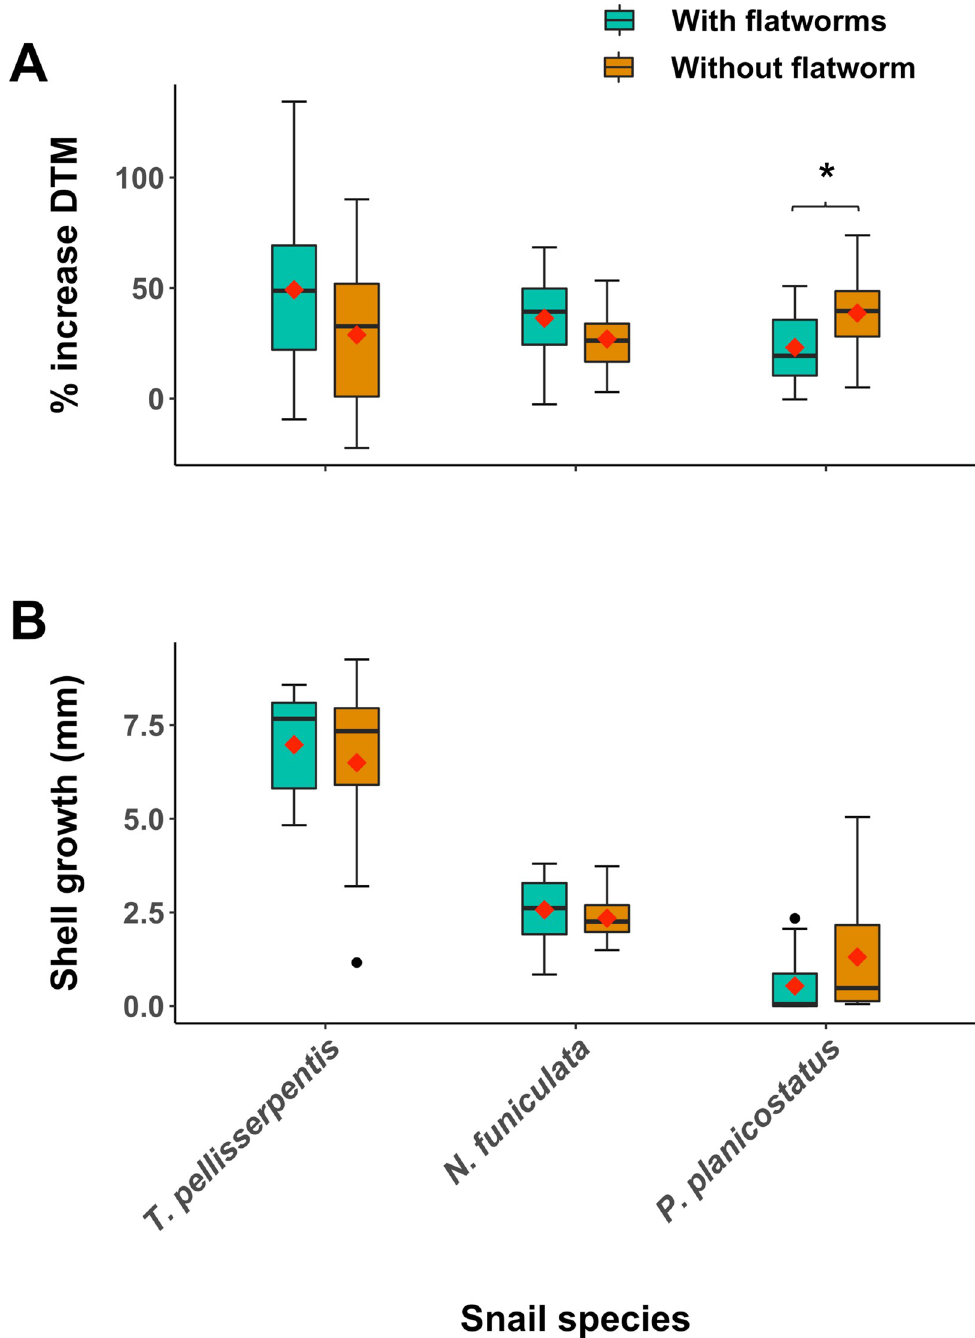
Fig 4. Effect of flatworm infestation on snail growth performances. Box plots of (A) percentage increase in snail dried tissue mass (DTM) and (B) growth in the shell aperture lip (mm) for Tegula pellisserpentis , Nerita funiculata , and Planaxis planicostatus with (turquoise box) and without (dark orange box) flatworms during the field experiment. Mean values for different treatment groups are represented by red diamond symbols. The asterisk ( � ) indicates a significant difference (P <